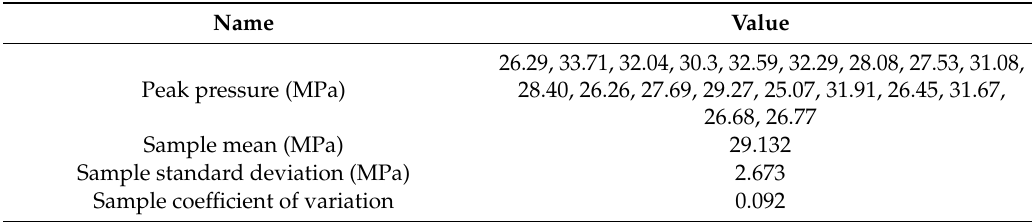
Table 11. The historical peak pressure data of the